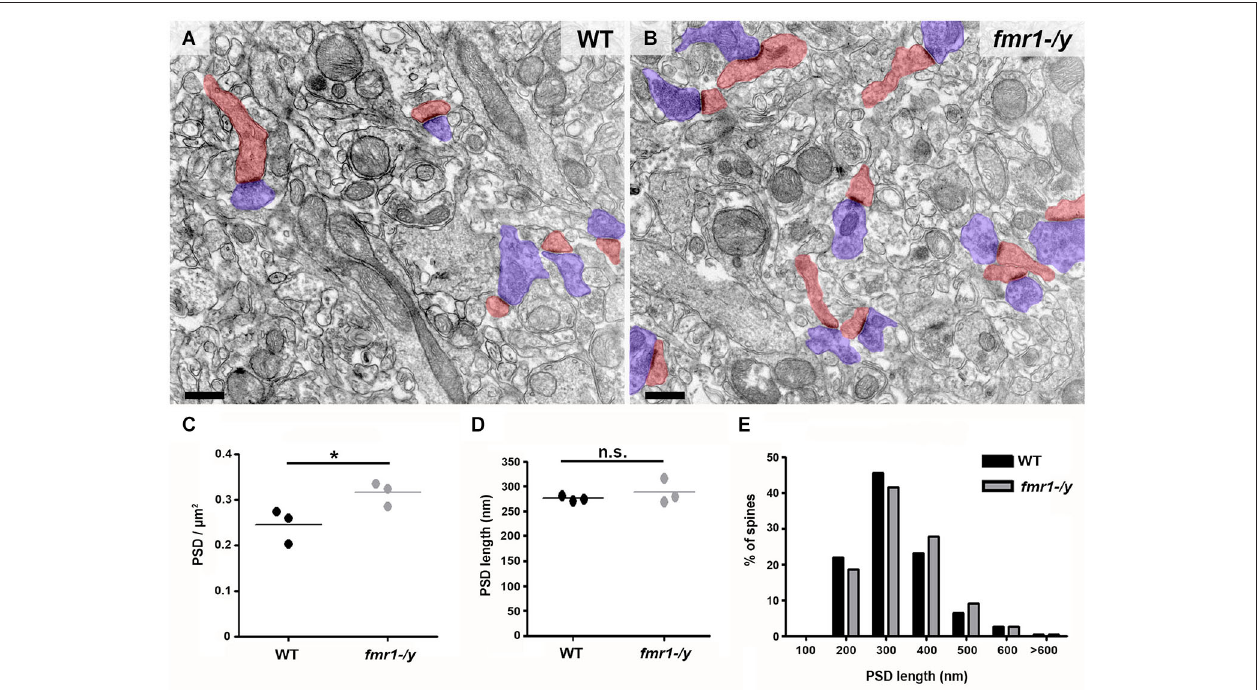
50 images per animal revealed a significant increase in excitatory synapse density in fmr1-/y mice ( n = 3) compared to wild-type ( n = 3). Unpaired t -test, p = 0.049. (D) Mean PSD lengths measured from 100 synapses per animal ( n = 3) revealed identical PSD length in the two genotypes. Unpaired t -test, p = 0.422. (E) Separation of PSD length values into 100 nm bins followed by a Chi-squared test, revealed no difference in PSD length distribution, p =